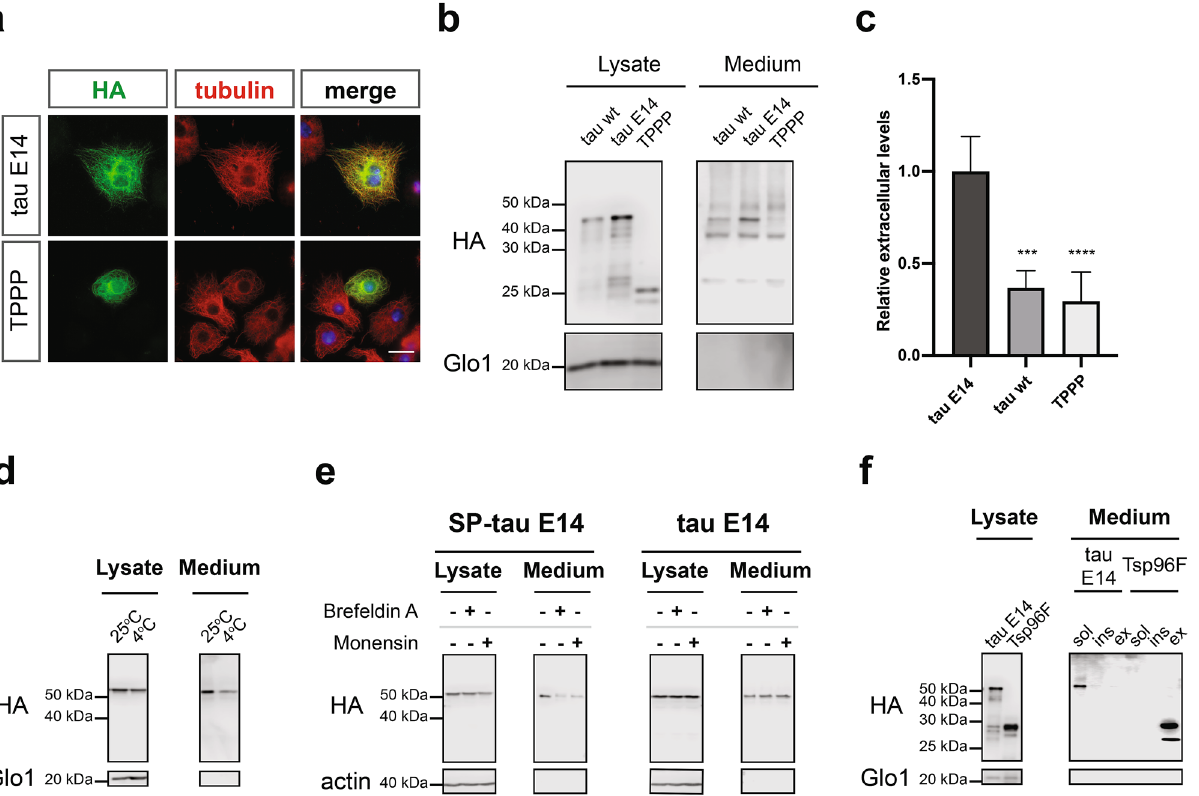
Figure 3. Phosphomimetic tau is secreted as a free protein via UPS Type I mechanisms. (a) Cells expressing tau E14 and TPPP were stained using HA antibody, while Hoechst dye was employed for the nucleus (scale bar, 15 µm). (b,c) Lysates and immunoprecipitated media were blotted against HA and Glo1. The densitometrically quantified secreted levels were initially normalized to the cell lysates and subsequently compared to tau E14. The data represent mean values ± s.d. derived from at least 3 biological replicates and were subjected to one-way ANOVA, followed by Tukey’s post hoc test. (d) Cell lysates and immunoprecipitated media from cells cultured for 6 h at normal conditions (25 °C) or at 4 °C were immunoblotted against HA and Glo1. (e) Lysates and immunoprecipitated medium from treated and untreated cells were immunoblotted against HA and actin. (f) Sarkosyl-insoluble and exosomal-associated proteins were isolated from conditioned media, while soluble and vesicle-free fractions were subjected to immunoprecipitation. All fractions were immunoblotted against HA, while Glo1 was used as loading and quality